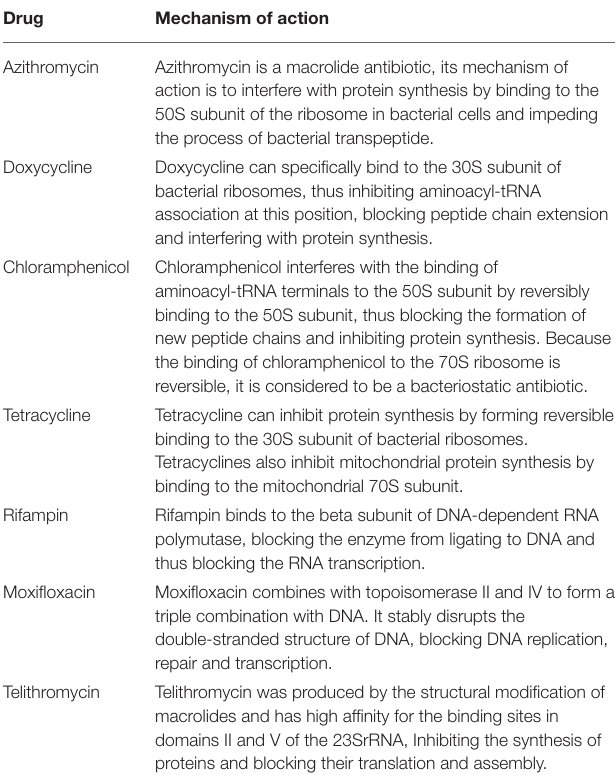
TABLE 2 | Main mechanisms of action of the included